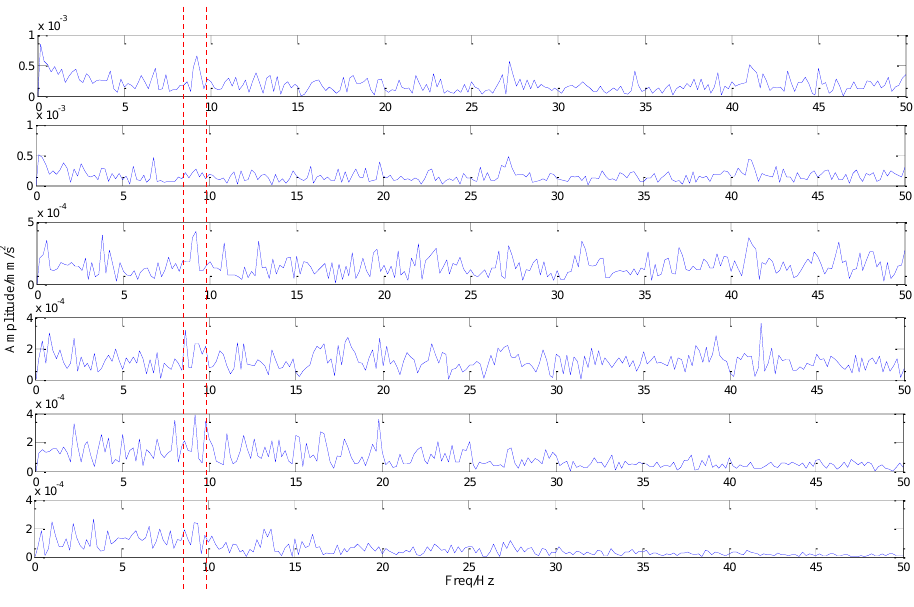
Figure 22. Result using EEMD.